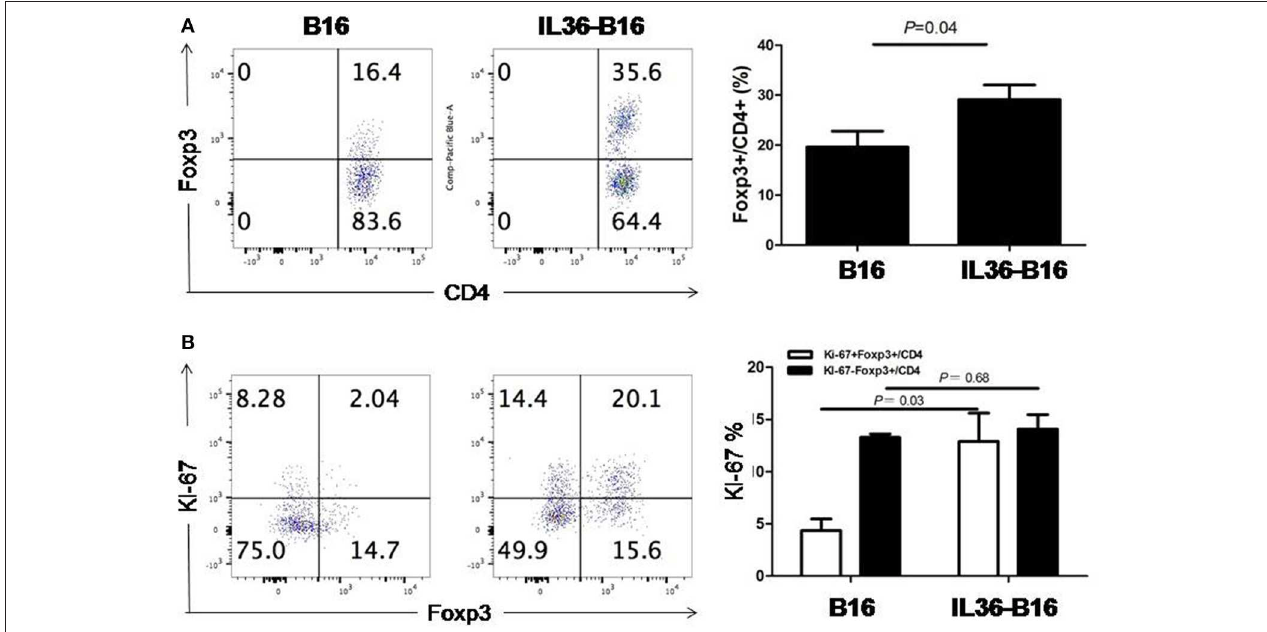
FIGURE 1 | IL-36 increased tumor infiltrated Treg cells and upregulated Ki-67 in Treg cells. A total of 10 4 B16 or IL-36-B16 cells was injected i.d. into C57BL/6j mice ( n = 3 mice/group). On day 10–12, tumors were resected and processed to generate single cell suspension. Percentages of Foxp3 + CD4 + T cells (A) in tumor infiltrating immune cells and percentages of Ki-67 + Foxp3 + cells (B) within the CD4 + TIL population were shown. Results are mean ± SEM of three independent